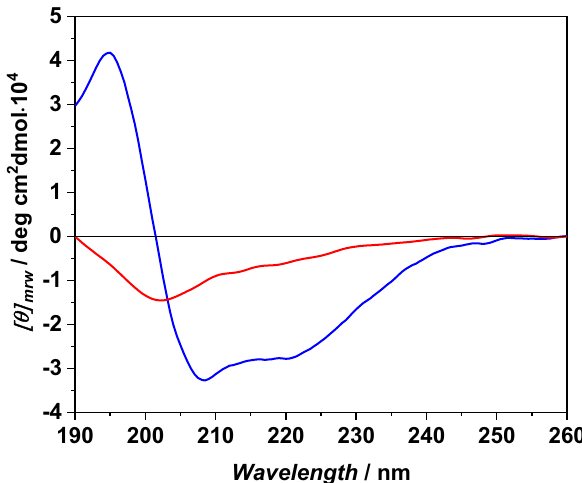
Figure 2. CD spectra of g-LL-III in the absence (red line) and presence of POPC/POPG LUVs at L/P 50 ratio (blue line). The spectra were acquired using a 0.1 cm path length quartz cuvette, in 10 mM phosphate buffer at pH 7.4 and temperature 25 °C.